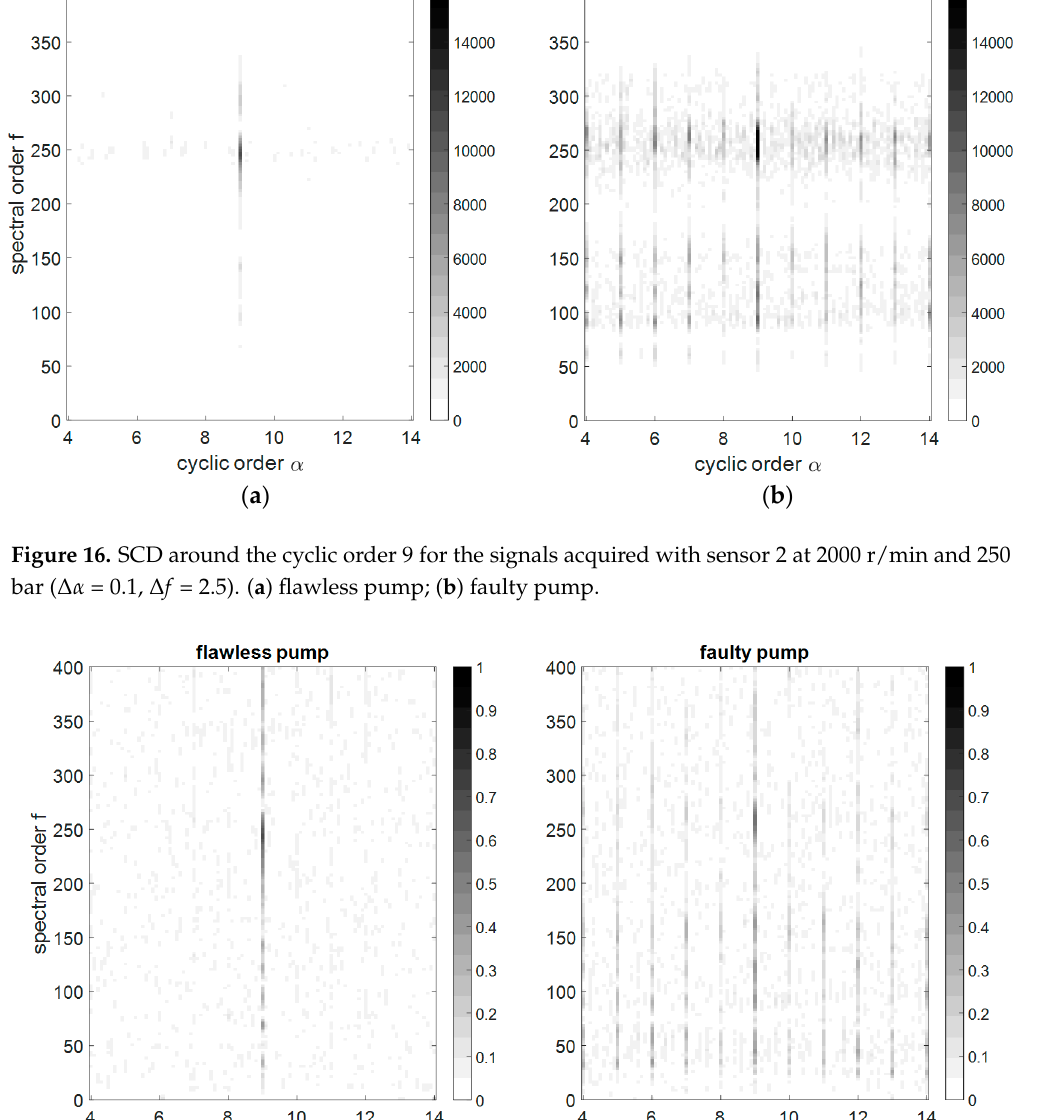
Figure 17. CSC around the cyclic order 9 for the signals acquired with sensor 2 at 2000 r/min and 250 bar ( ∆ α = 0.1, ∆ f = 2.5). ( a ) flawless pump; ( b ) faulty pump. bar ( ∆ α = 0.1, ∆ f = 2.5). ( a ) flawless pump; ( b ) faulty